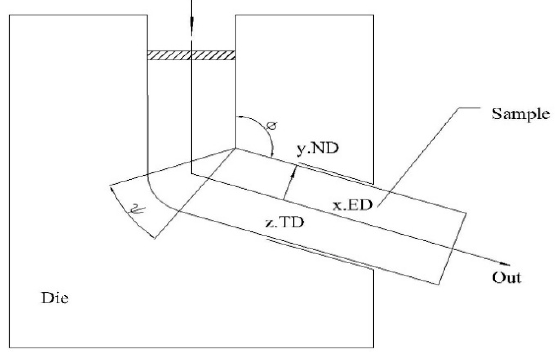
Figure 1. Equal channel angular pressing (ECAP) mold diagram.